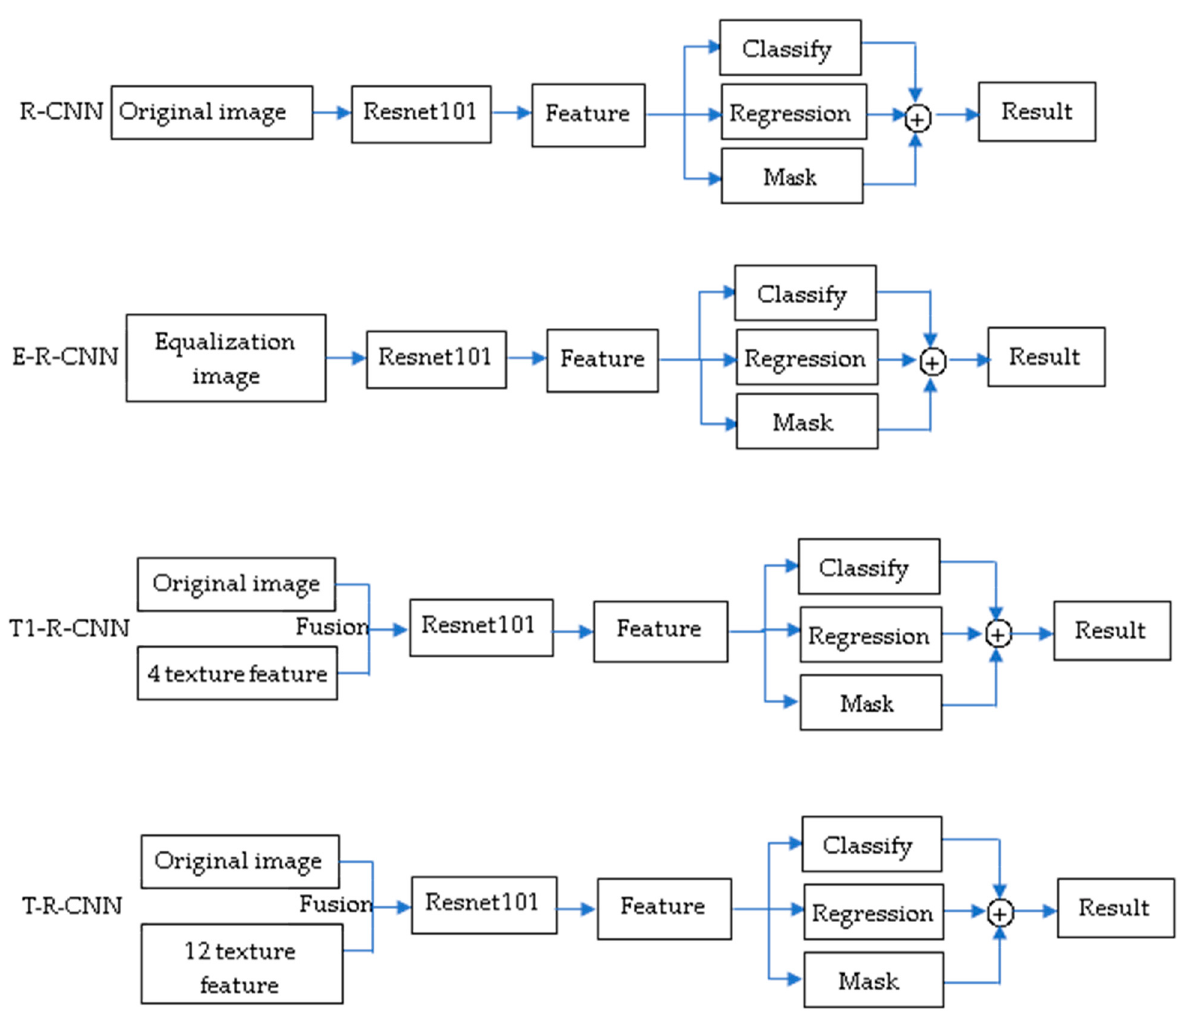
Figure 2. Comparison